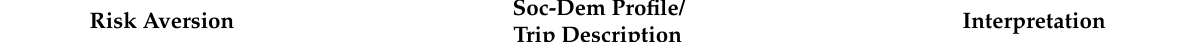
Table 8. Cluster interpretation for